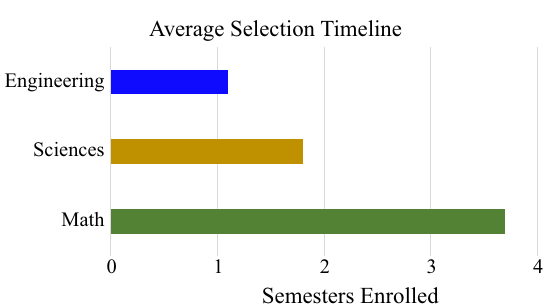
Fig. 5 Average selection semester per field of